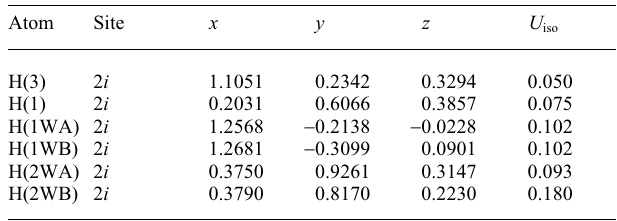
Table 2. Atomic coordinates and displacement parameters (in Å 2 )